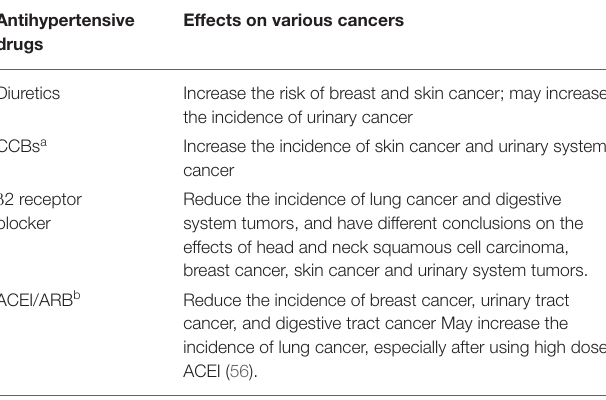
TABLE 1 | Impact of commonly used antihypertensive drugs on cancer